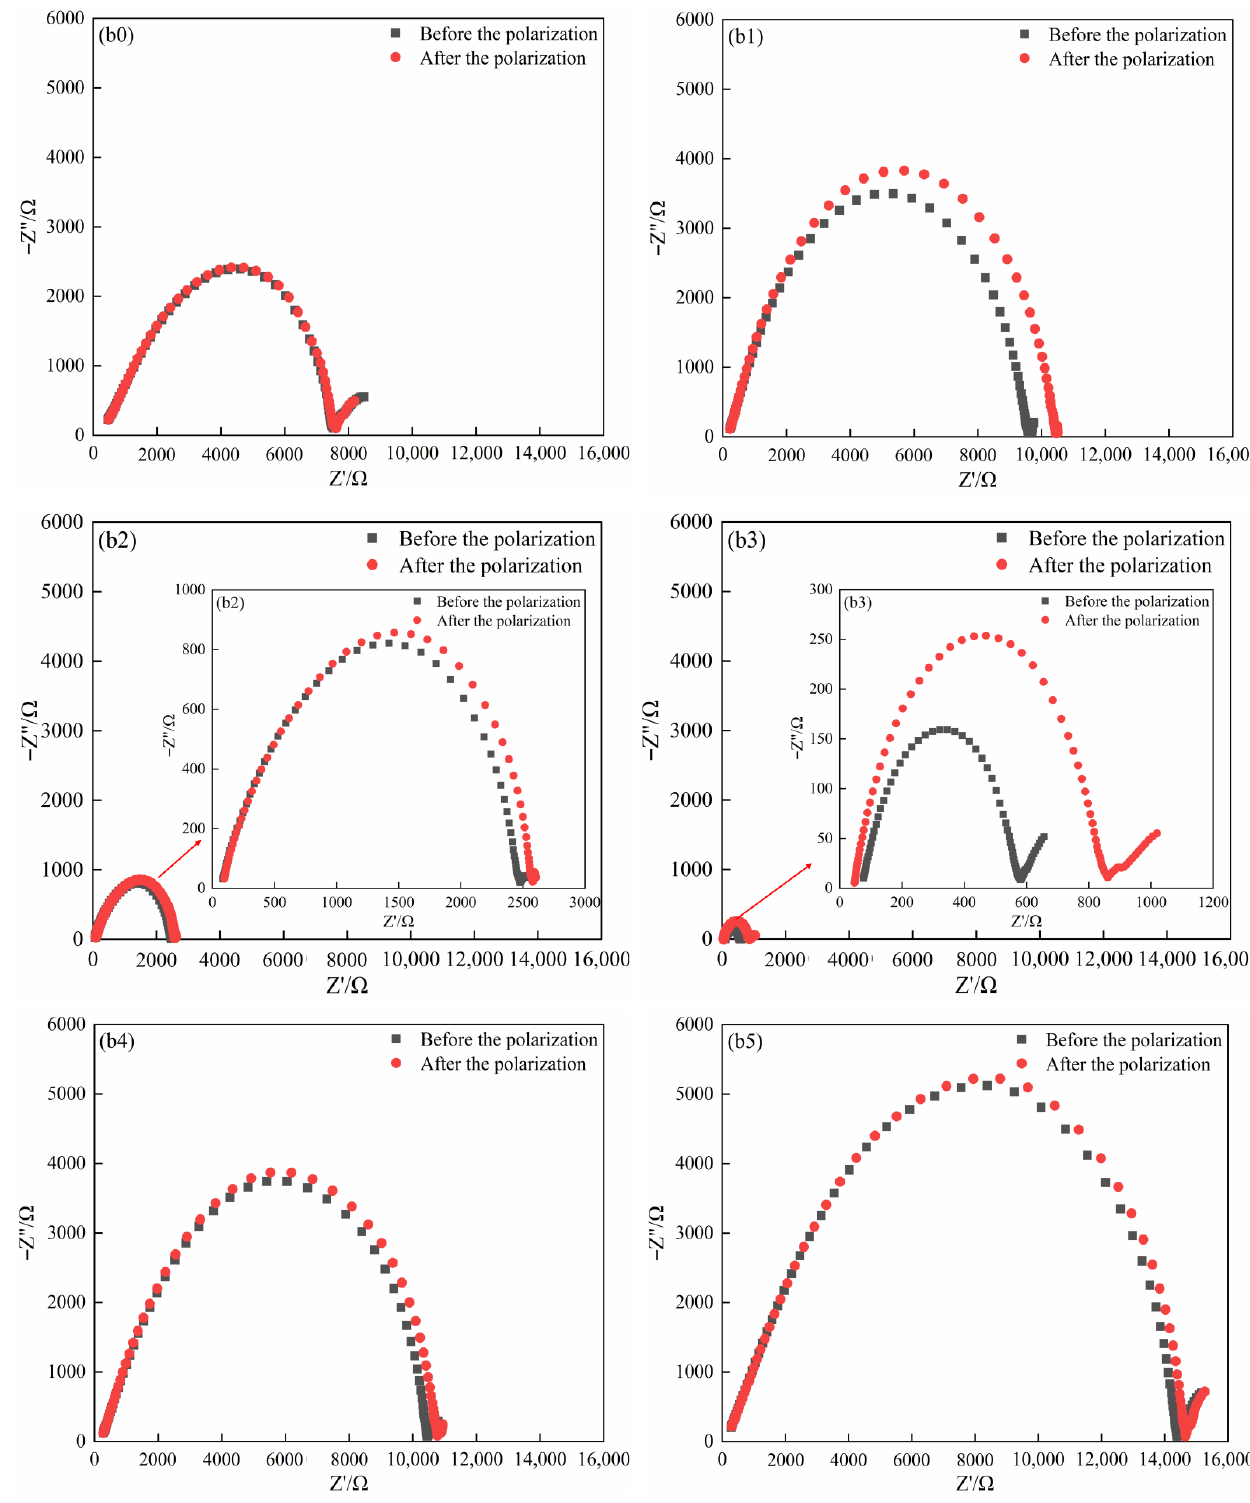
Figure 5. Polarization ( a0 – a5 ) and EIS curves ( b0 – b5 ) of pre-polarization and post-polarization of the SPEs in the symmetrical coin cell (Li (lithium sheet)/SPE/Li) at 60 °C, ( a0 , b0 ) 0 wt.% ZnO [26], ( a1 , b1 ) 1 wt.% ZnO, ( a2 , b2 ) 2 wt.% ZnO, ( a3,b3 ) 3 wt.% ZnO, ( a4 , b4 ) 4 wt.% ZnO, and ( a5 , b5 ) 5 wt.% ZnO.